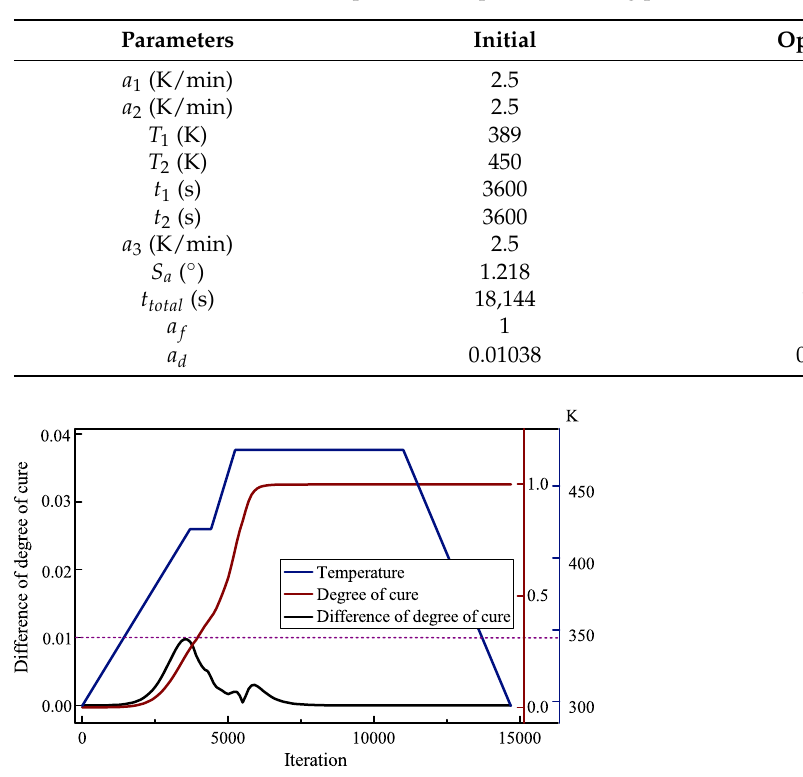
Table 6. Parameters of initial cure profile and optimized curing profile.